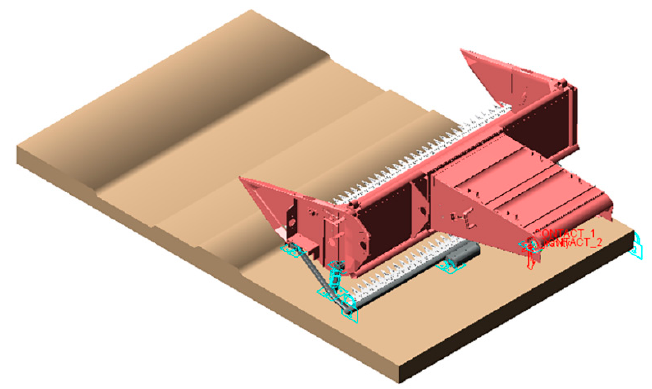
Figure 9. Simulation model.